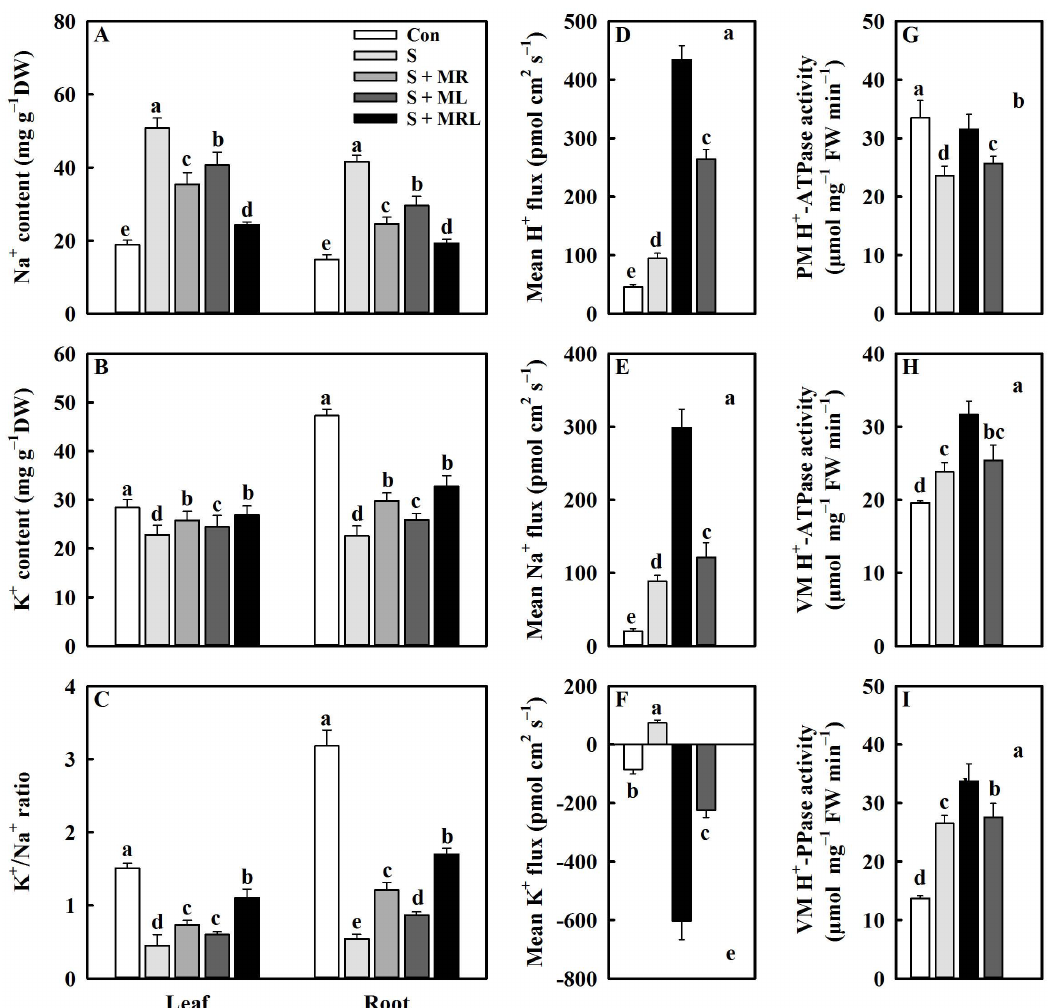
Figure 4. Effect of different methods of melatonin application on ion homeostasis, ion flux, and H + -pump activities of sugar beet seedlings under salt stress. ( A ) Na + content, ( B ) K + content, and ( C ) K + /Na + ratio in the leaves and roots. The fluxes of ( D ) H + , ( E ) Na + , and ( F ) K + in the roots; positive values indicate efflux, and negative values indicate influx. The activities of ( G ) PM H + -ATPase, ( H ) PM H + -ATPase, and ( I ) VM H + -PPase in roots. Con, control treatment; S, salt stress treatment; S + MR, salt stress treatment + root application of melatonin; S + ML, salt stress treatment + foliar application of melatonin; S + MRL, salt stress treatment + combined root and foliar applications of melatonin. Data show the means ± standard errors ( n = 4). Different letters indicate significant differences between treatments according to Duncan’s multiple range test ( p <